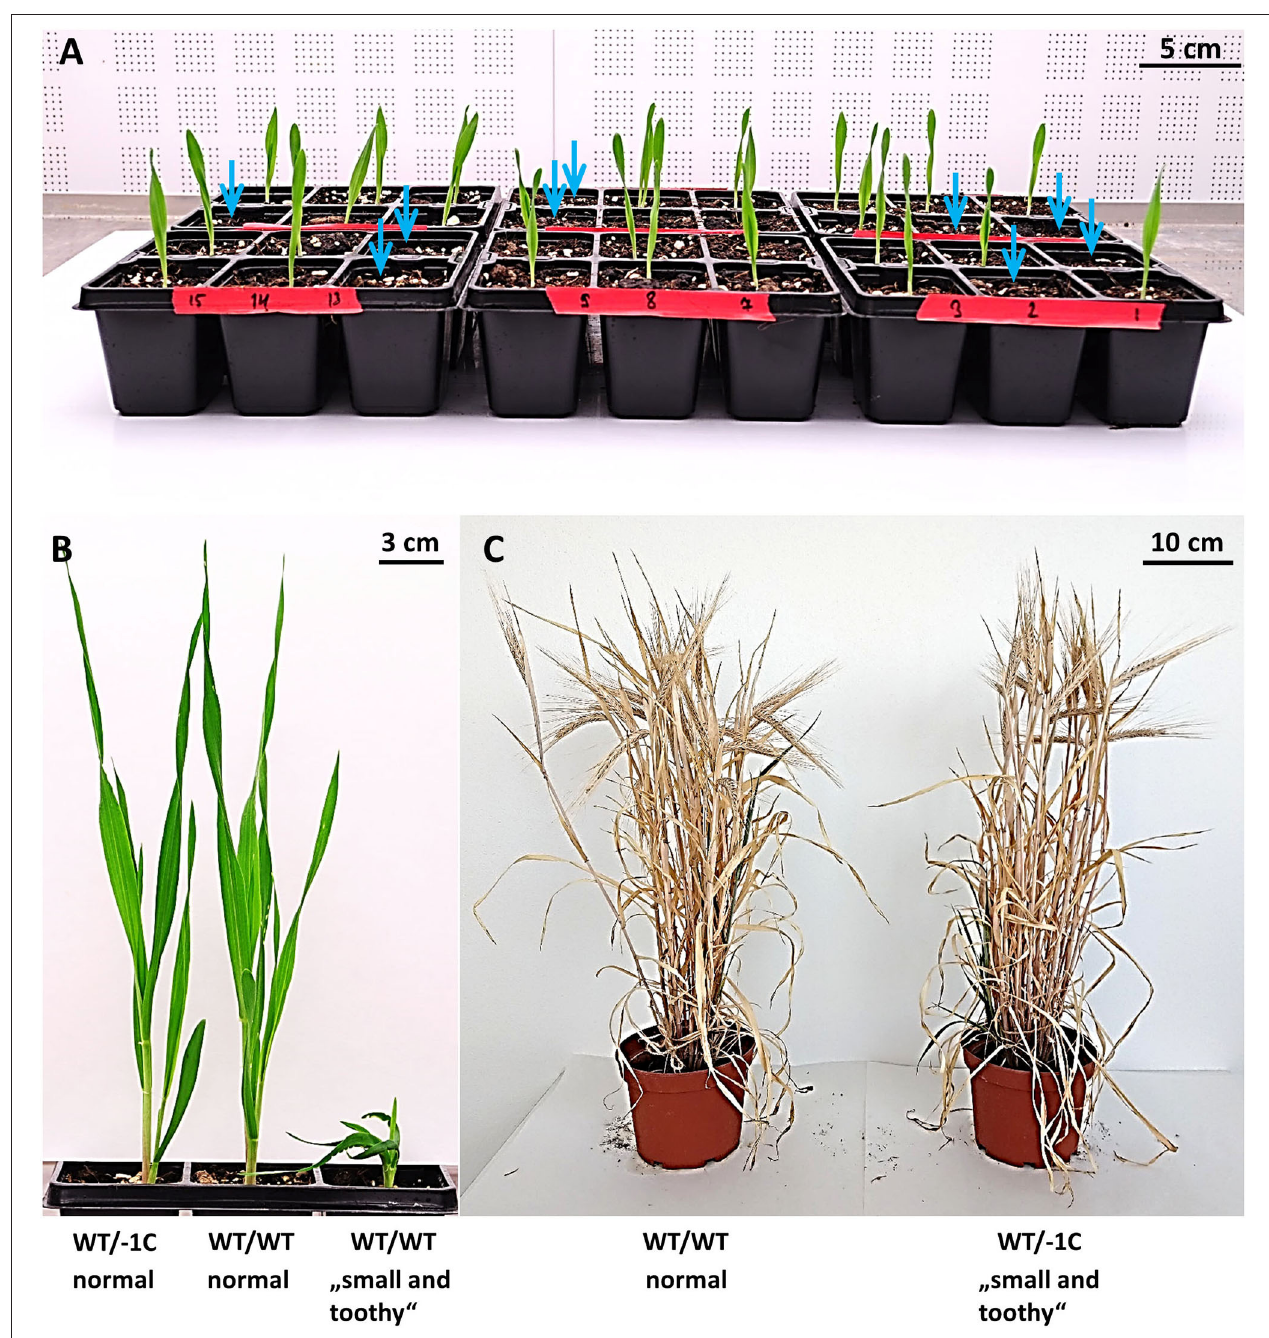
FIGURE 3 | Seedling emergence and phenotypes of emerged plants in the progeny of heterozygous mutants in the HvMPK6 gene (WT/ − 1C). (A) Seedling emergence of the T3 progeny of A1 heterozygous mutant (WT/ − 1C). A single grain was sown in each pot of the planter. Seedlings were 7 days old when photographed. Light blue arrows indicate pots with no plant emergence. (B) A 4 weeks old normal heterozygous mutant (WT/ − 1C), normal WT (WT/WT), and rare “small and toothy” (WT/WT) transgenic plant. T3 progeny plants of A2 heterozygous mutant (WT/ − 1C) are shown. There were no obvious macroscopical phenotype differences between normal heterozygous mutant and normal WT transgenic plants. The rare “small and toothy” phenotype was associated with both heterozygous mutant and WT transgenic plants. (C) When transferred to a larger pot, “small and toothy” plants fully recovered during ontogenesis. The images of T2-generation transgenic mature plants are shown. The plant on the left is a normal WT (WT/WT) transgenic plant and the plant on the right is a heterozygous mutant (WT/ − 1C), which displayed the “small and toothy” phenotype at the seedling stage.